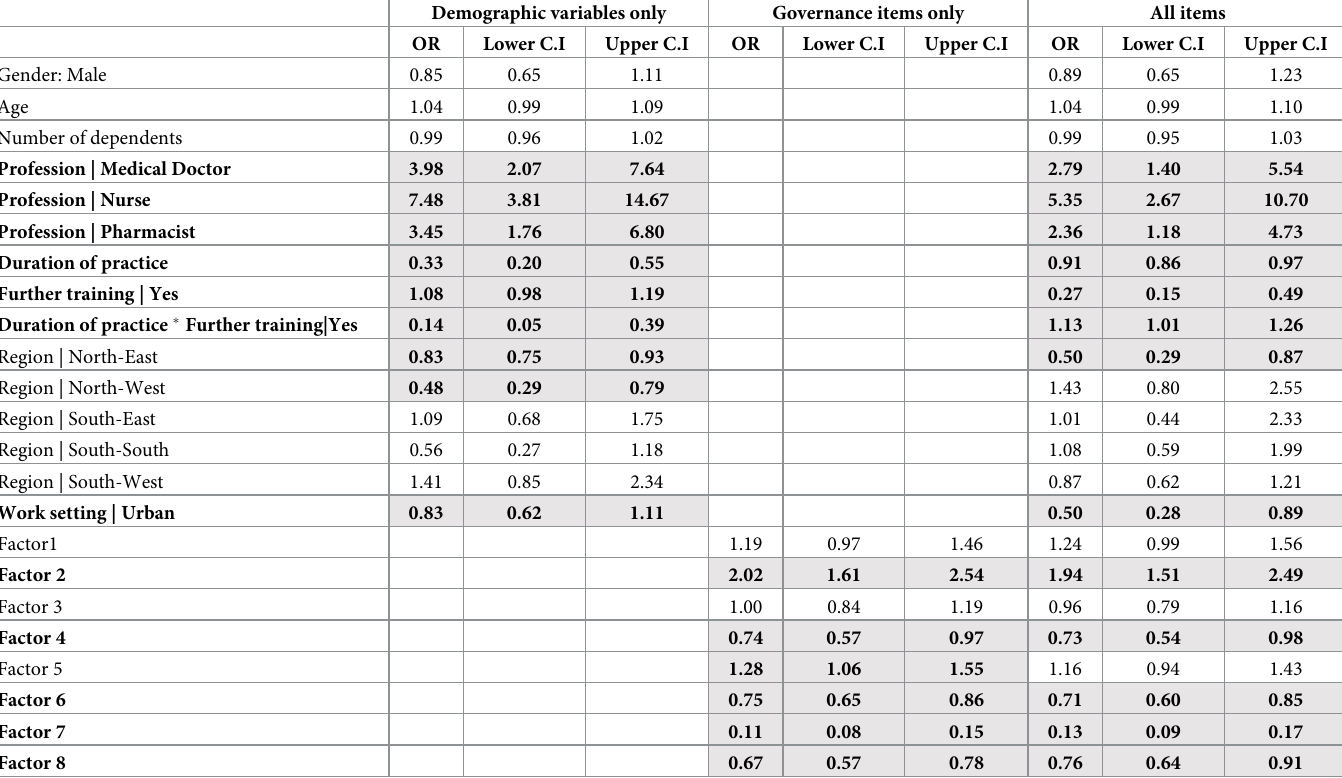
Table 3. Multivariate analysis involving SHWs who wish to stay (reference) versus those who wish to migrate from